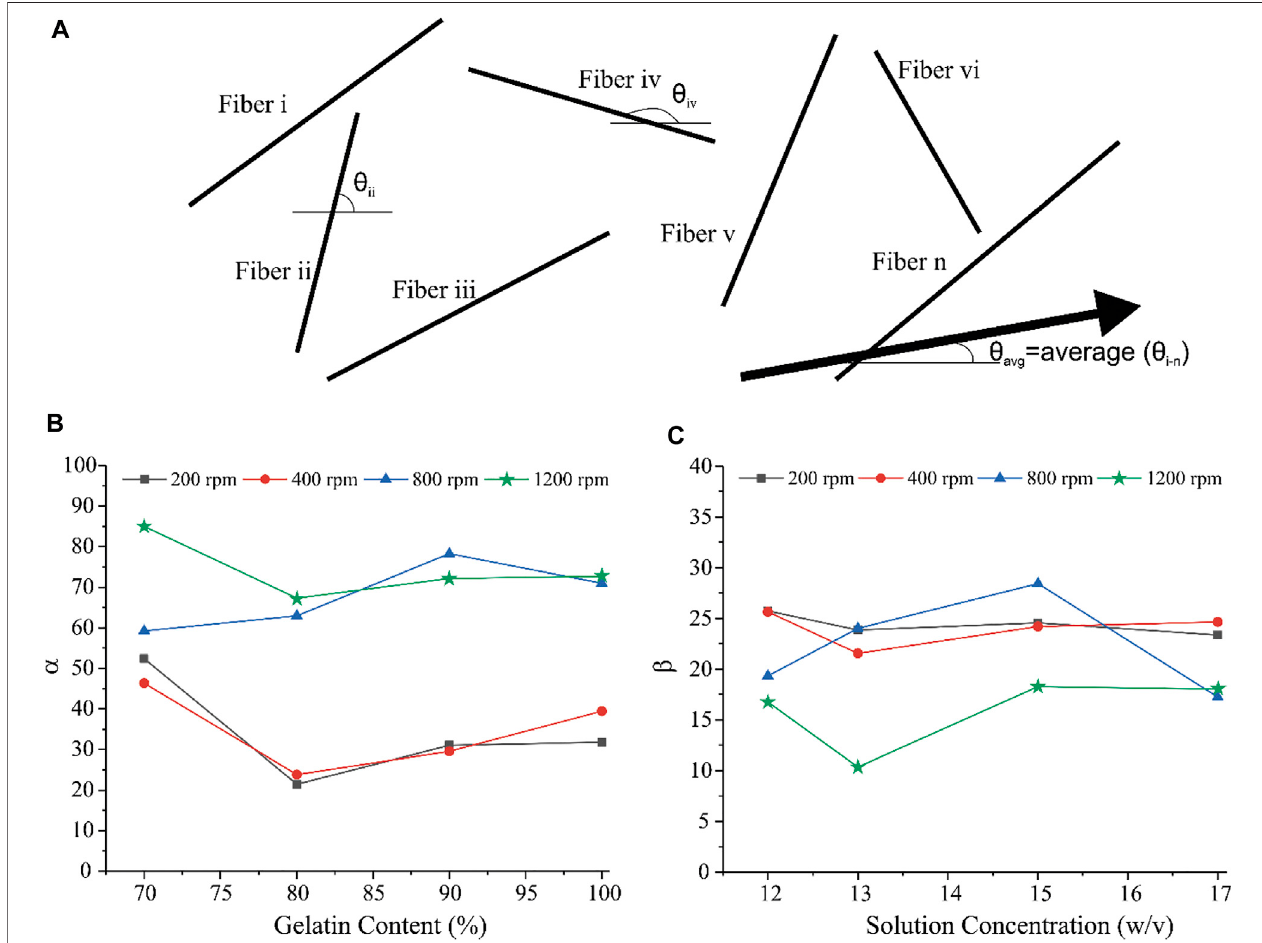
FIGURE 2 | (A) schematic illustration of fi ber alignment. (B) Variation of α with respect to polymer weight ratio and (C) variation of ß with respect to solution concentration.